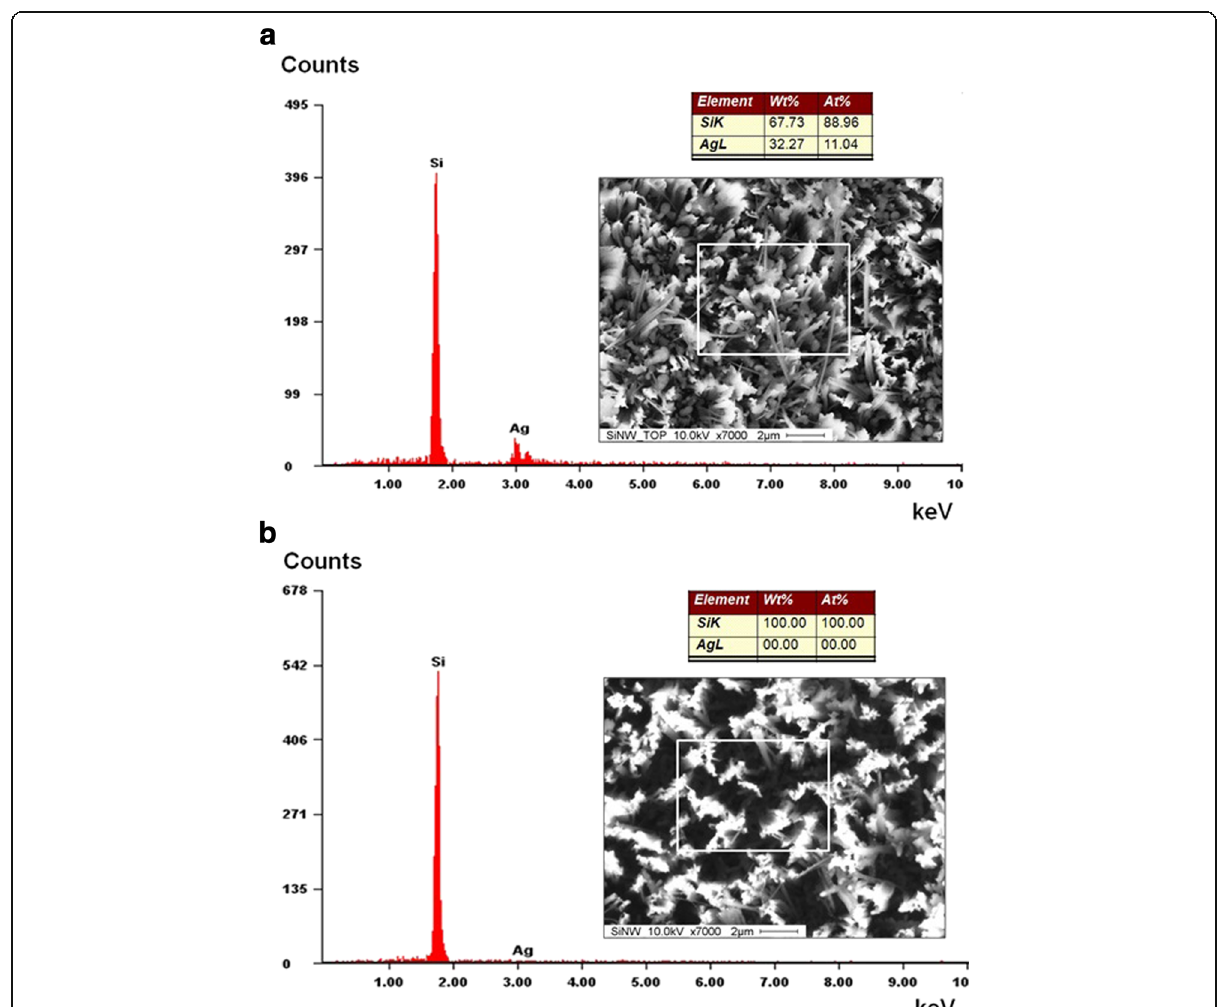
Fig. 4 EDX analysis results of SiNW arrays after the etching processes: a before aqua regia cleaning (88.96 at.% Si and 11.04 at.% Ag) and b after aqua regia cleaning (100.00 at.% Si and 0.00 at.%